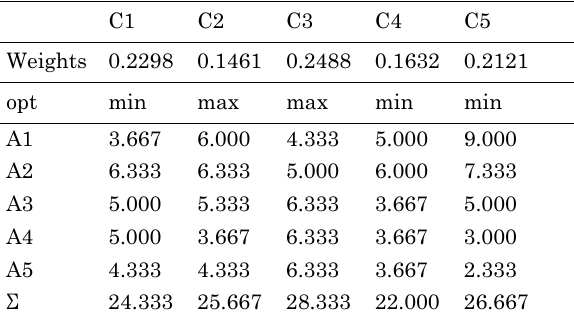
Table 5. Initial decision-making matrix with values of the attributes describing the compared alternatives